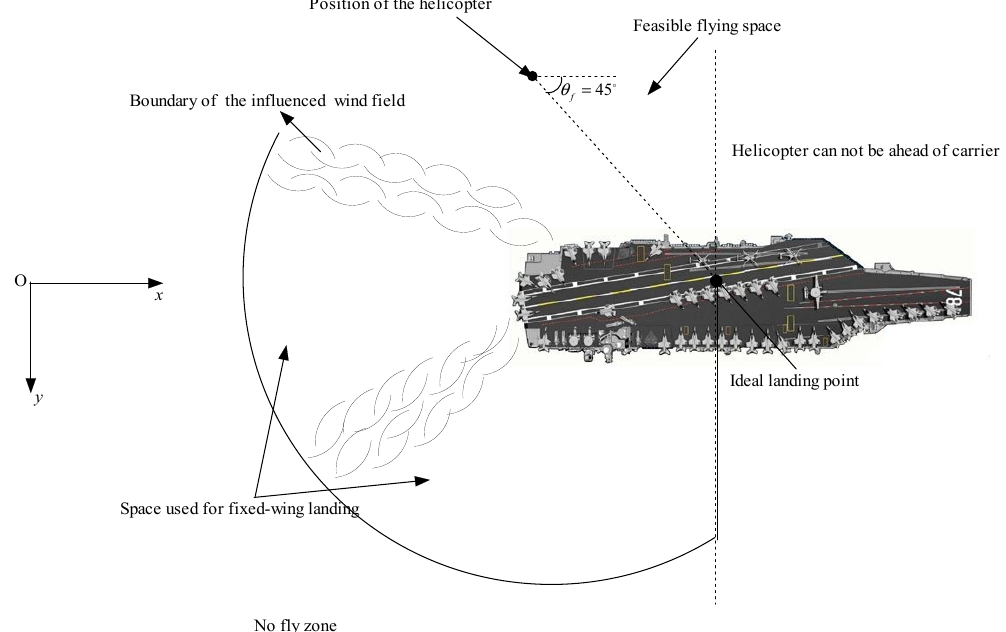
Figure 3. Diagram of feasible flying space in the landing task.